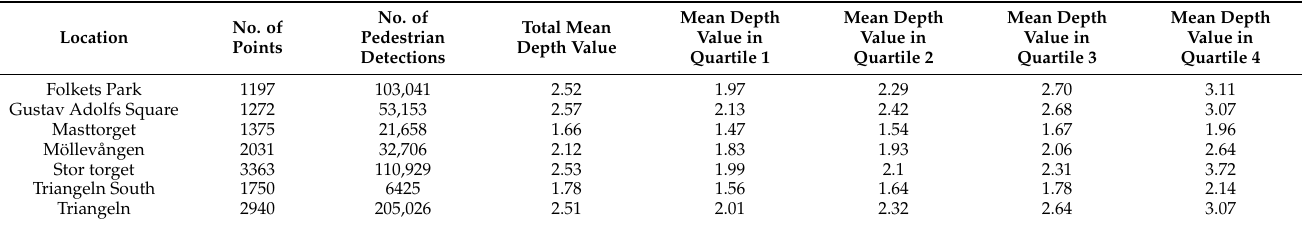
Table 2. Number of points included in the polygon map and total number of pedestrian detections at each location.